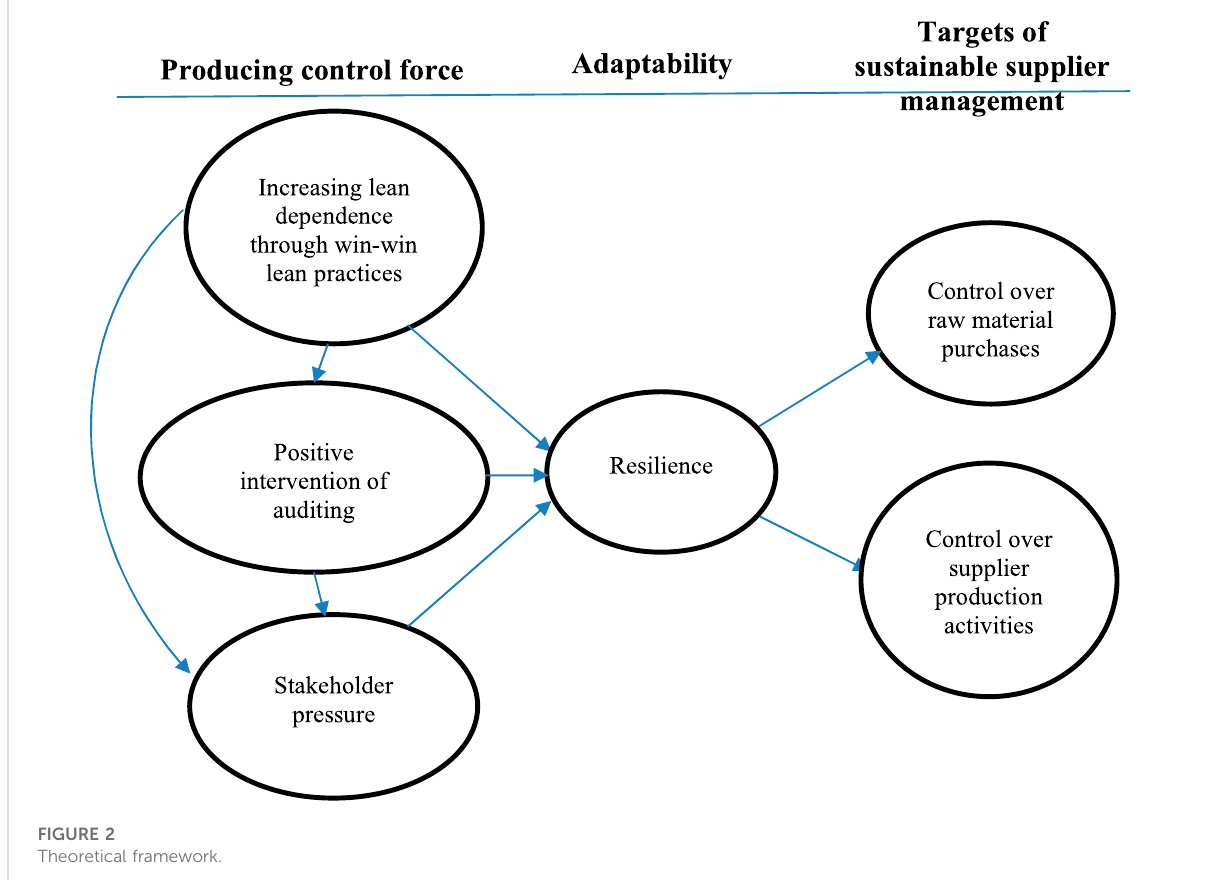
FIGURE 2 Theoretical